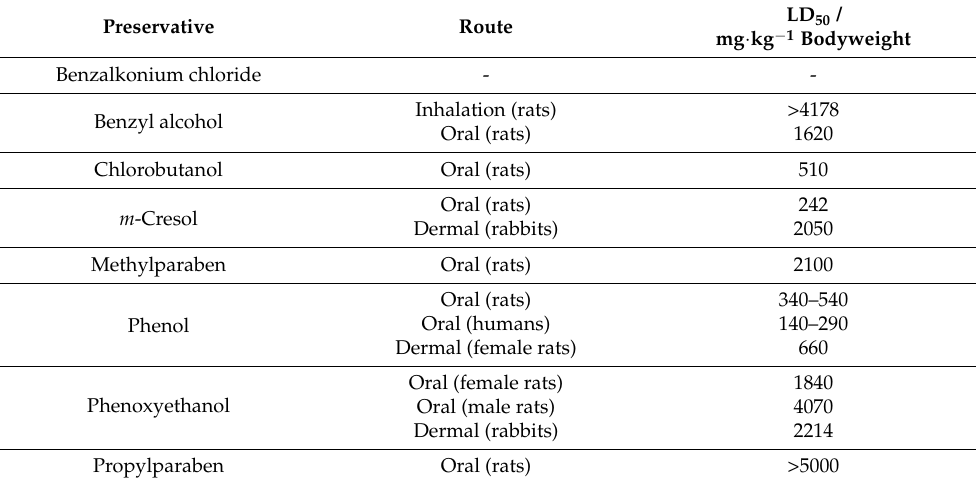
Table 8. List of LD 50 according to the European Chemical Agency (ECHA) and European Medicines Agency